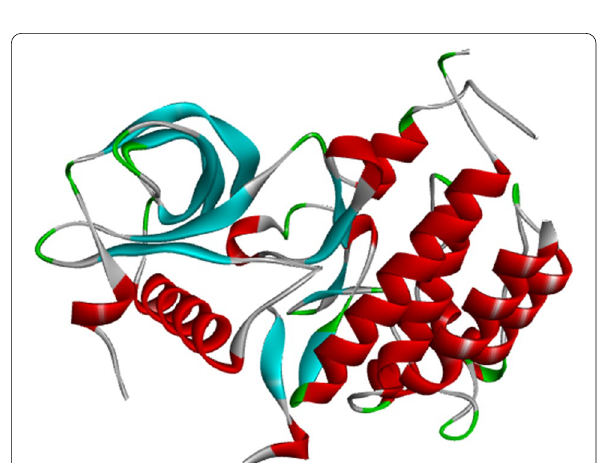
Fig. 6 3D structure of VEGFR-2 (pdb id: 4agd)